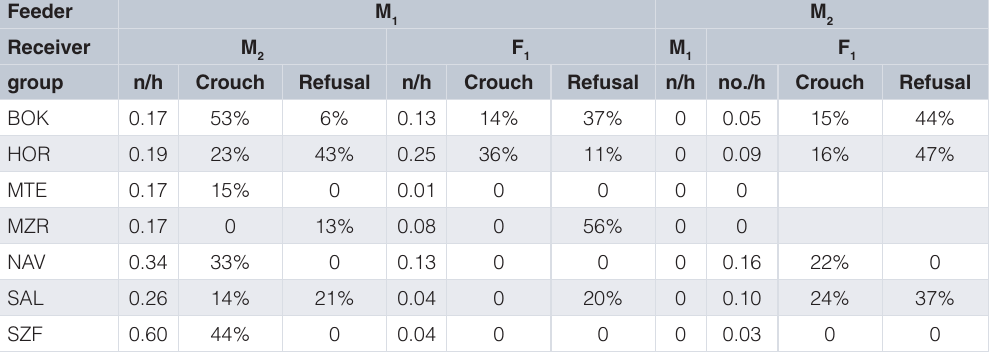
Table 4. Number of allofeedings by M crouch= accepting as a fledgling (percentage of interactions); refusals (percentage of interactions). Feeder M